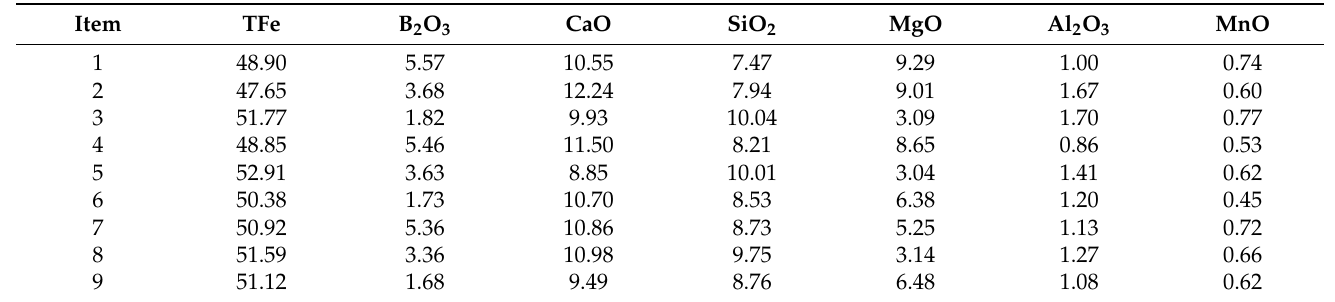
Table 7 exhibits the chemical composition of the ludwigite sinters. Table 7. Chemical composition of ludwigite